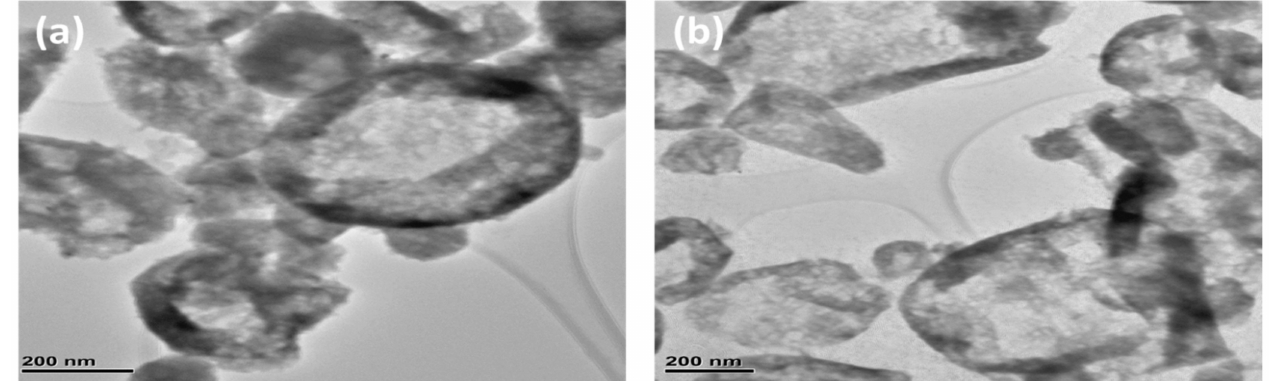
Figure 4. TEM micrographs of synthesized NiS at: ( a ) 400 ◦ C; ( b ) 450 ◦